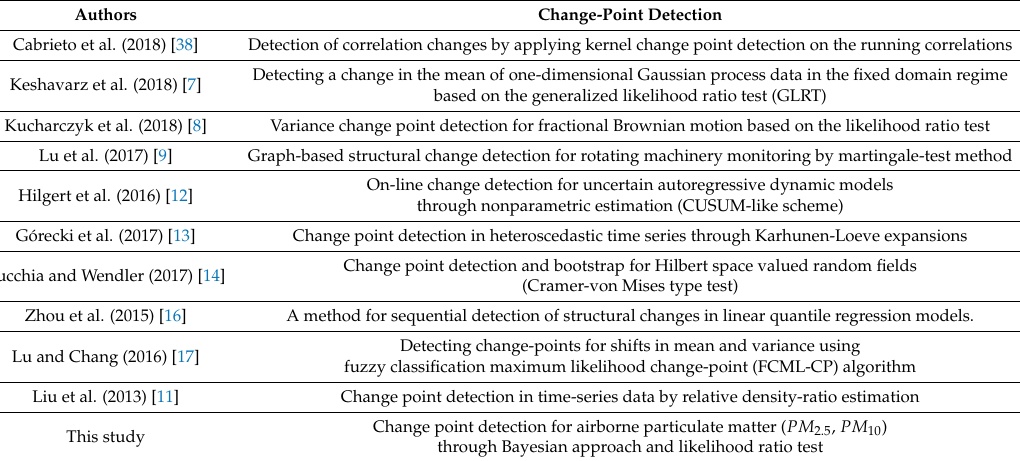
Table 2. Change point detection.